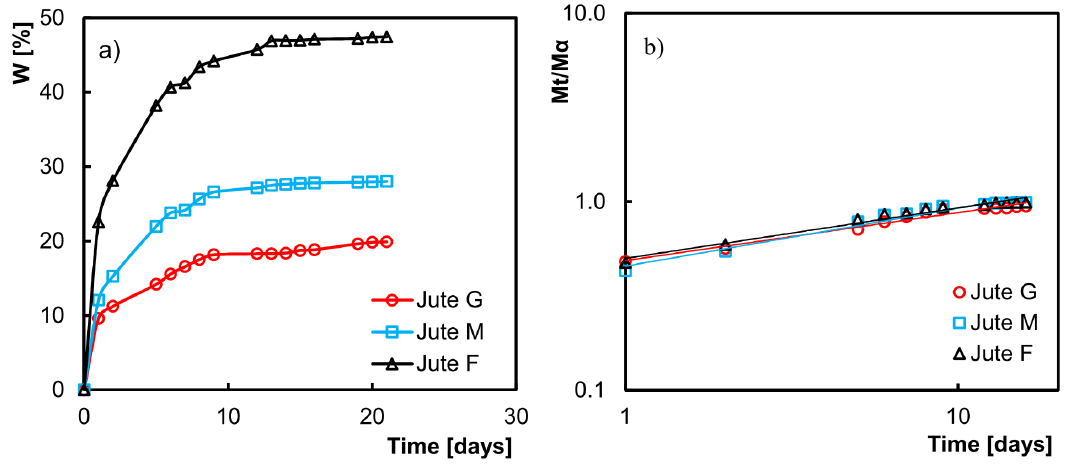
Figure 3. Water absorption results: a) water absorption versus time; b) Mt/Mα versus